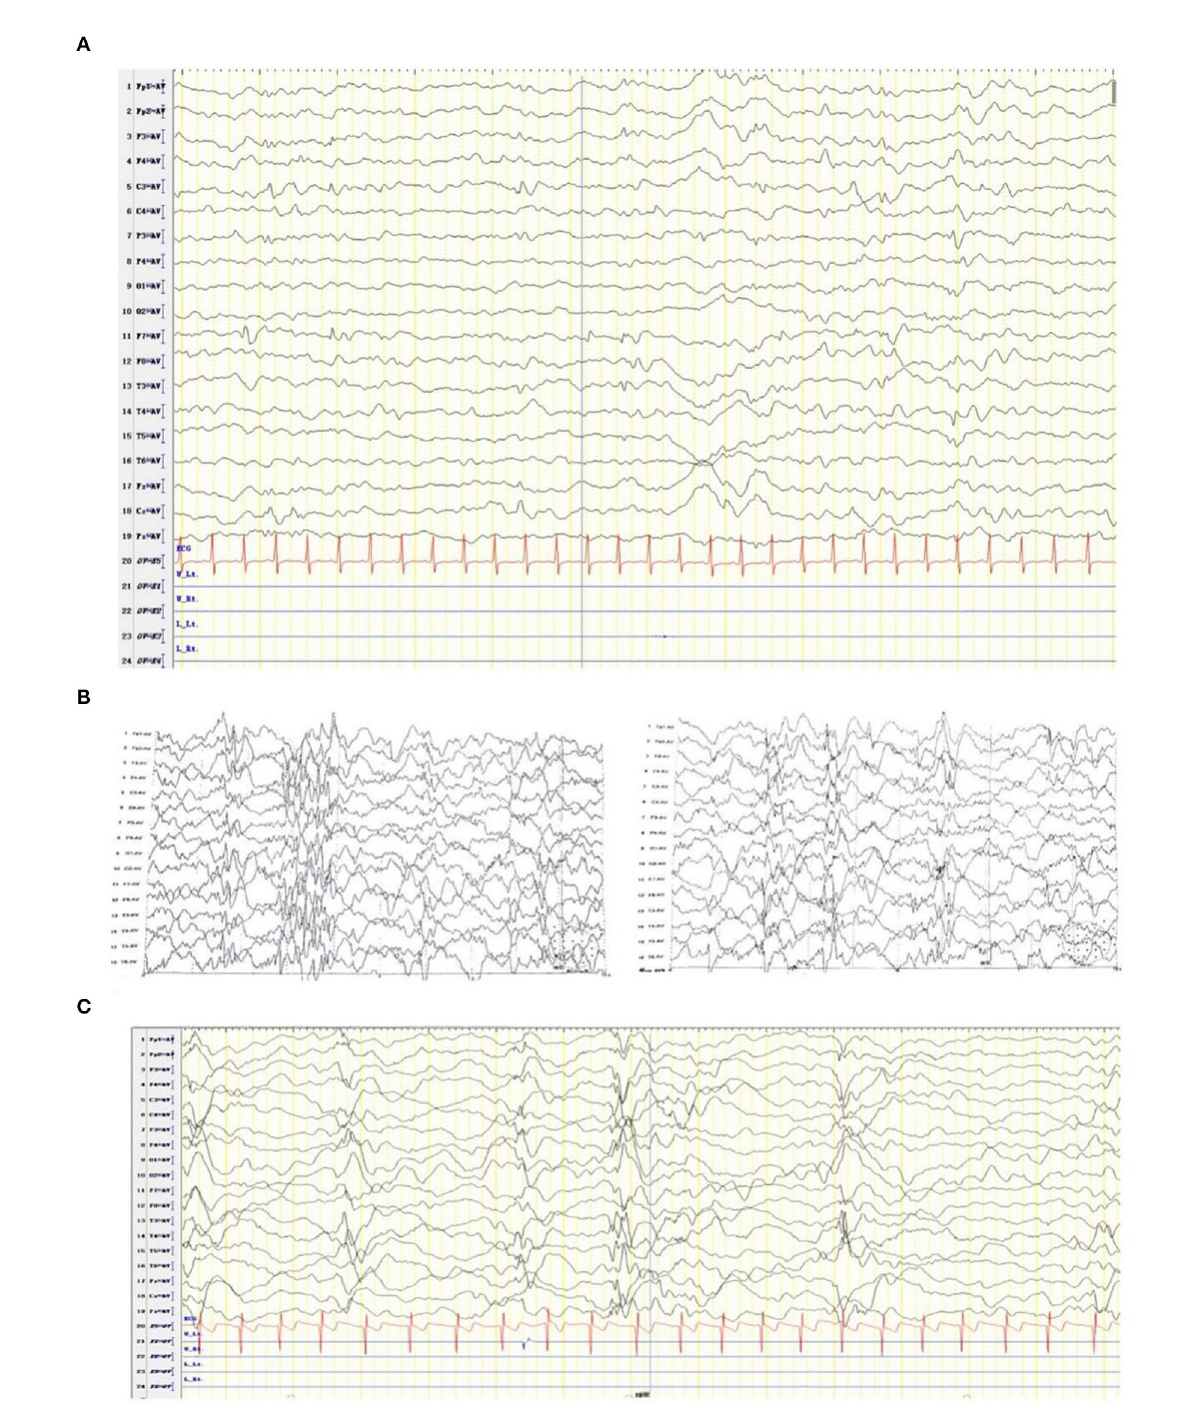
FIGURE3 Sanger sequencing (A) confirmed the mutation NM_000944.5(PPP3CA):c.1258_125 9 insAGTG on exon 12 (B) and the pattern diagram of PPP3CA functional domains (C) .